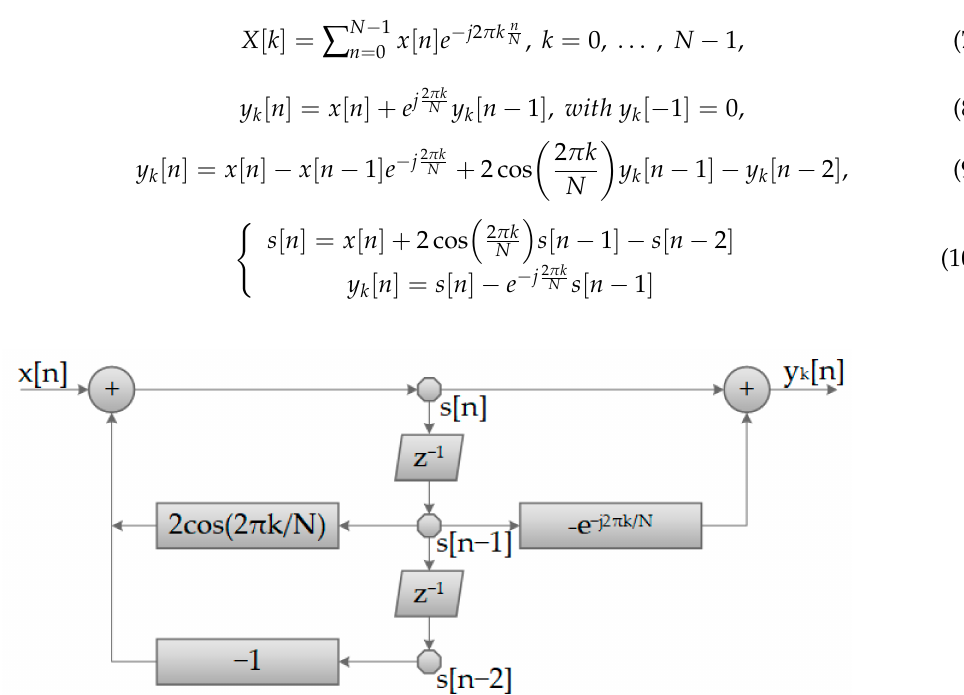
Figure 5. Block diagram of the second order Goertzel algorithm.